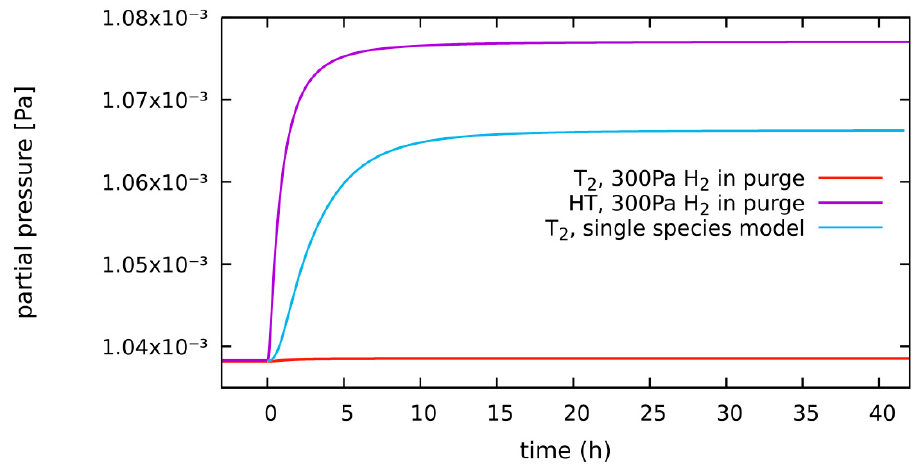
Figure 17. Transient tritium flow through patch interfaces breeder to and from steel, and steel to and from coolant for surface-limited conditions. The results of the single- and two-species models obviously match.